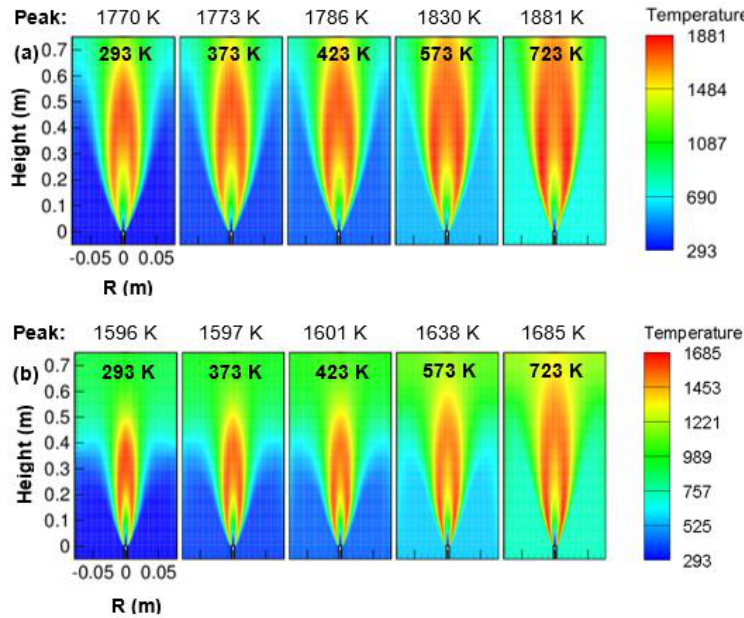
Figure 15. Contours of temperature varying with air temperature; ( a ) 1 atm, and ( b ) 3 atm.